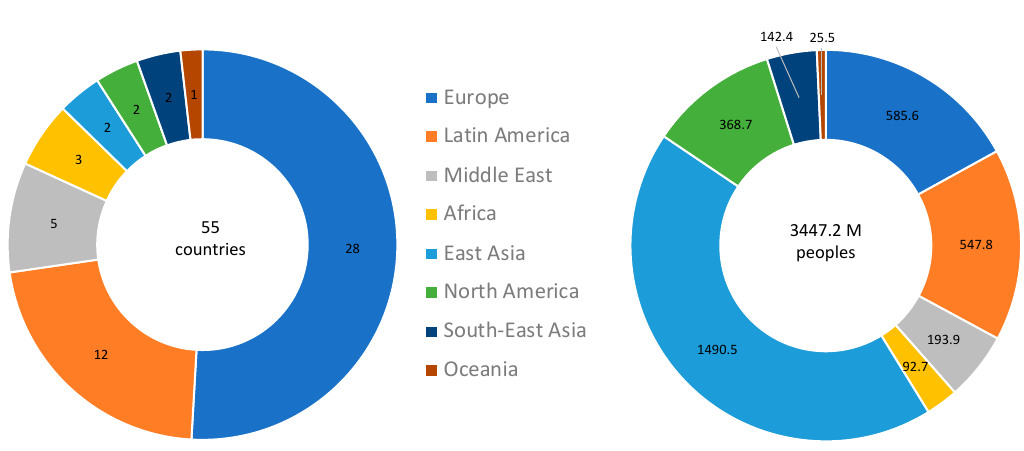
Figure 1. Countries analyzed in this study by geographical regions. Countries that comply with the predetermined thresholds for the population size and a minimum rate of deaths per million (DPM) at the analysis date are included. These countries (55 total) are partitioned by their geographical regions ( left ) and the cumulative population within each region ( right ).